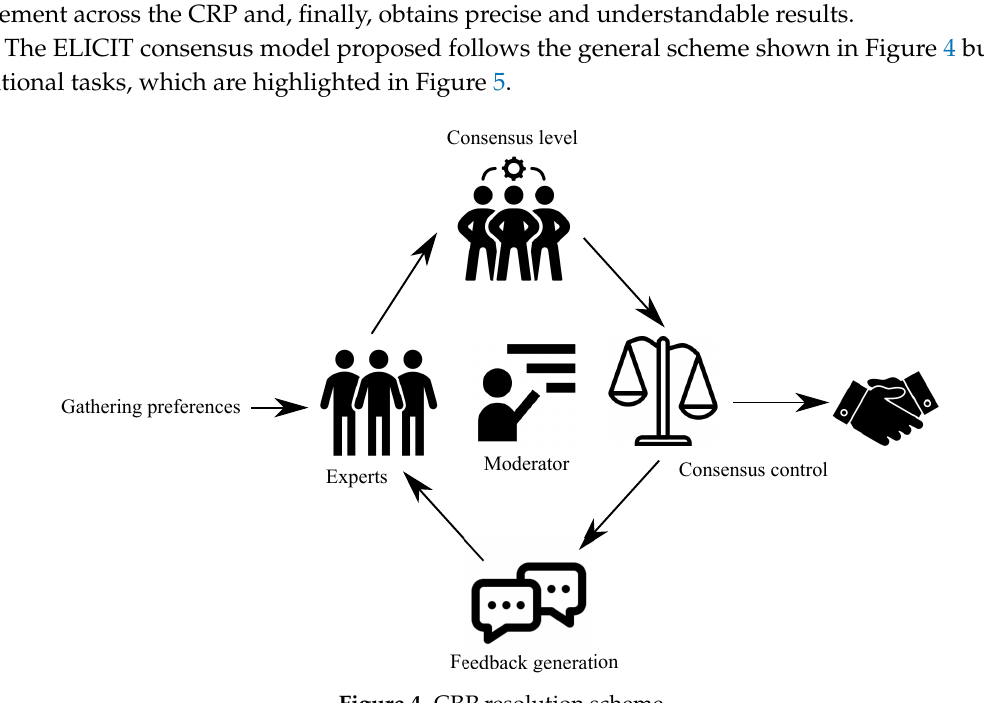
Figure 4. CRP resolution